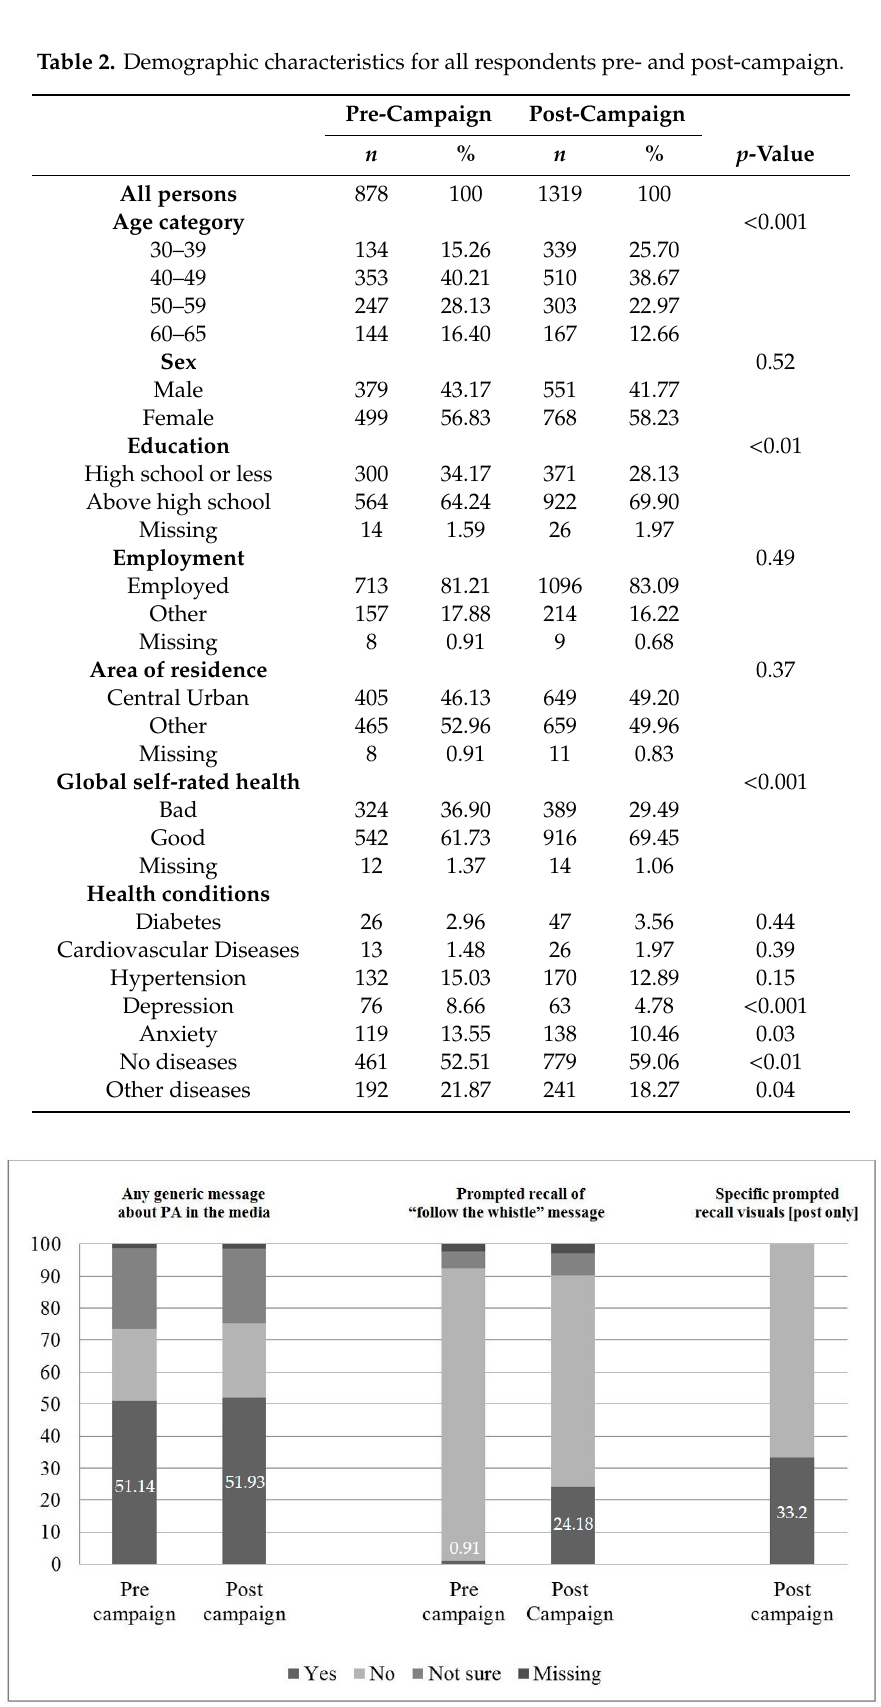
Figure 2. Campaign recall (%) (generic, text prompted, and visuals prompted).